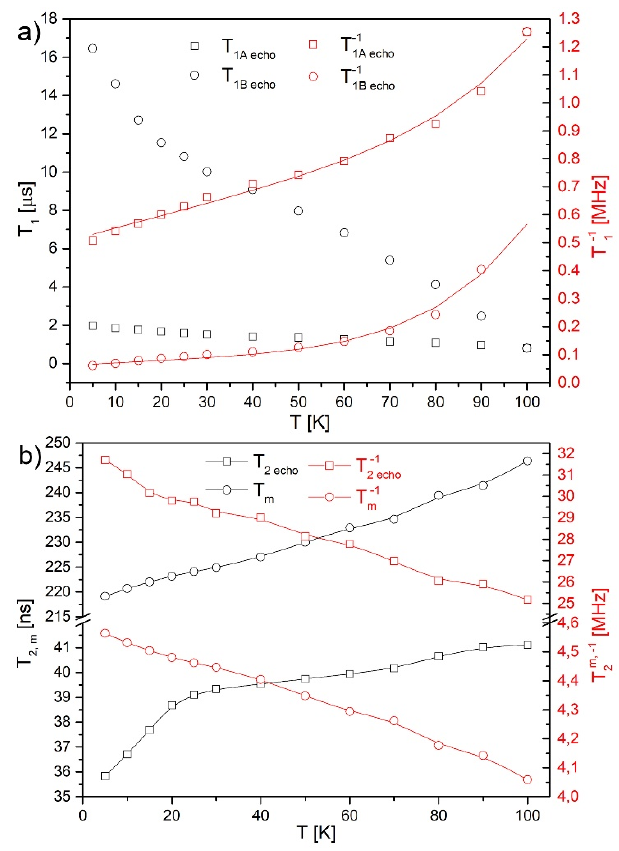
Figure 8. ( a ) Spin–lattice (T 1 ), and ( b ) spin–spin (T 2 ) and phase memory relaxation times, with fits, and Figure 8. (a) Spin–lattice (T 1 ), and (b) spin–spin (T 2 ) and phase memory relaxation times, with fits, their rates recorded from echo inversion as a function of temperature. and their rates recorded from echo inversion as a function of temperature. Table 1. Components of di ff erent relaxation processes for two paramagnetic